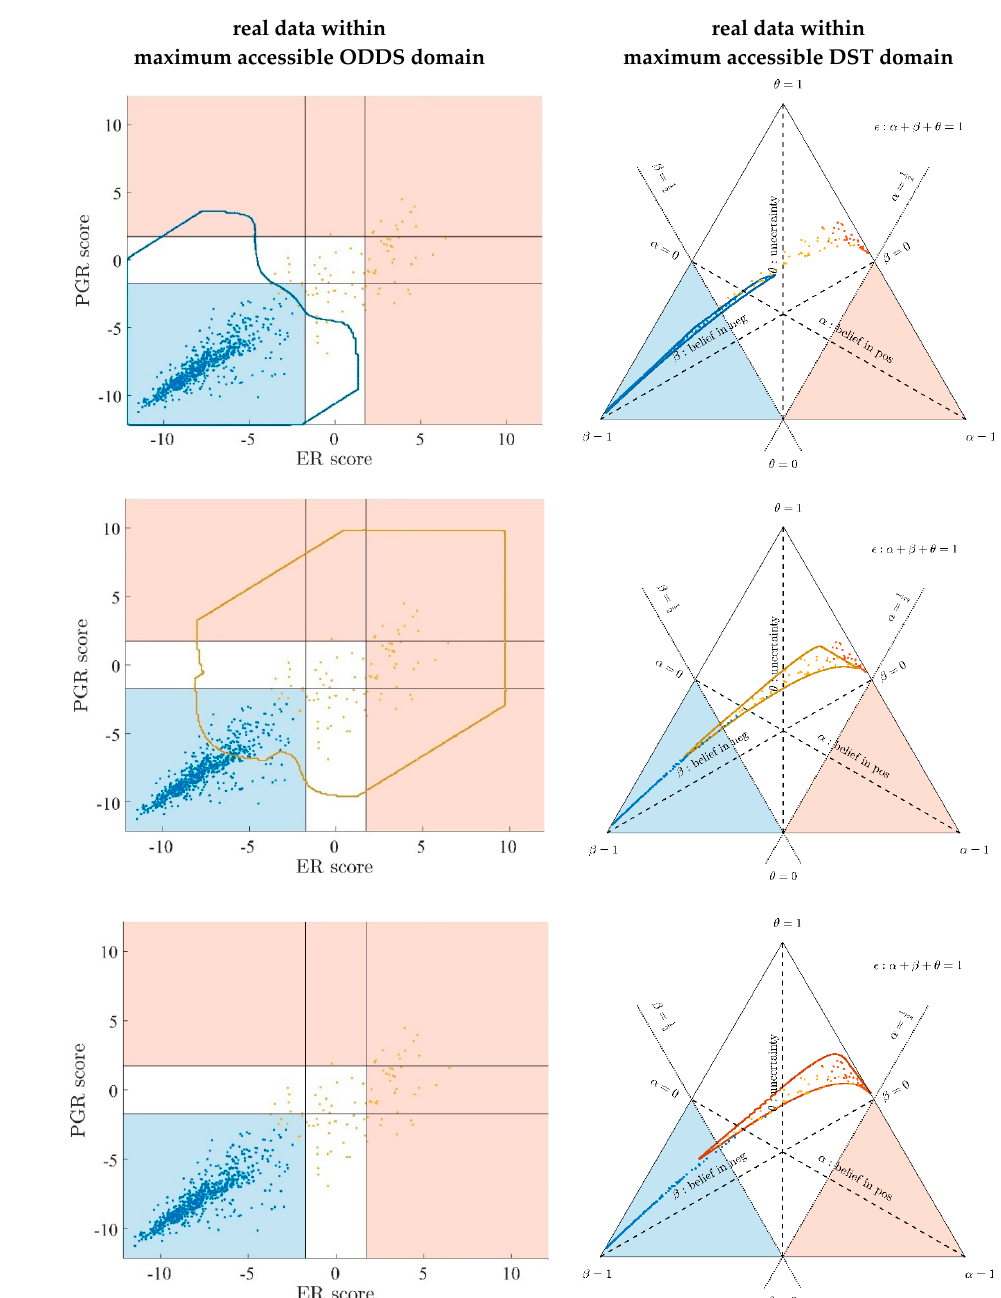
Figure A3. Real sample data within maximum accessible domains for IHC = ( − , − ). Left column: Real data shown in coordinates of ODDS prediction scores. Square in light blue (bottom left): criterion for negative predictions according to ODDS. Area in light red: criterion for positive predictions according to ODDS. In between (white): area of inconclusive ODDS predictions. Outlined areas represent maximum domains accessible for DST predictions, displayed in ODDS coordinates. Sample data, located according to their ODDS prediction scores but colored according to DST prediction (neg ˆ = blue, inc ˆ = beige, pos ˆ = red). Right column: Real data shown in ternary coordinates of DST prediction evidence. Triangle in light blue (bottom left): criterion for negative predictions according to DST. Triangle in light red (bottom right): criterion for positive predictions according to DST. White, kite-shaped area: criterion for inconclusive DST predictions. Outlined areas represent maximum domains accessible for ODDS prediction, displayed in DST coordinates. Sample data, while being located according to DST evidence is colored, however, according to ODDS prediction. Rows 1–3 : Negative, inconclusive